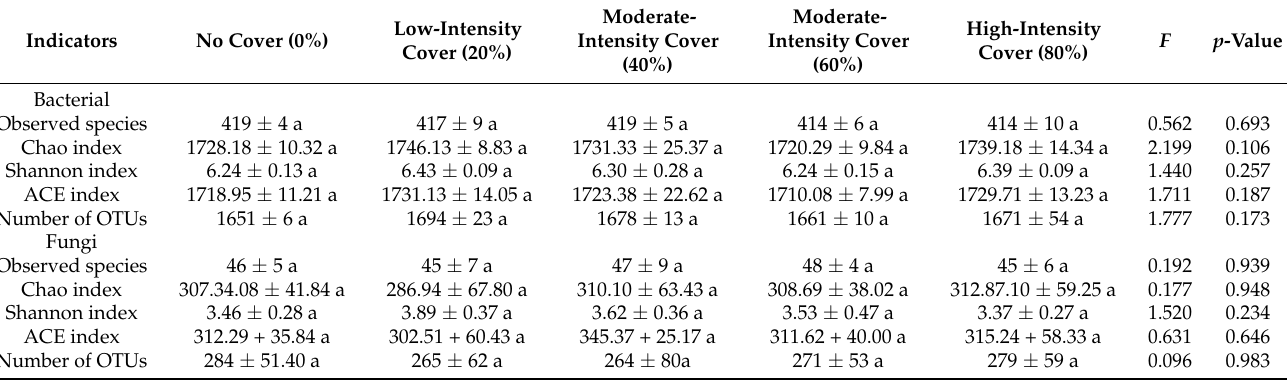
Table 2. Soil diversity and richness for different treatments.